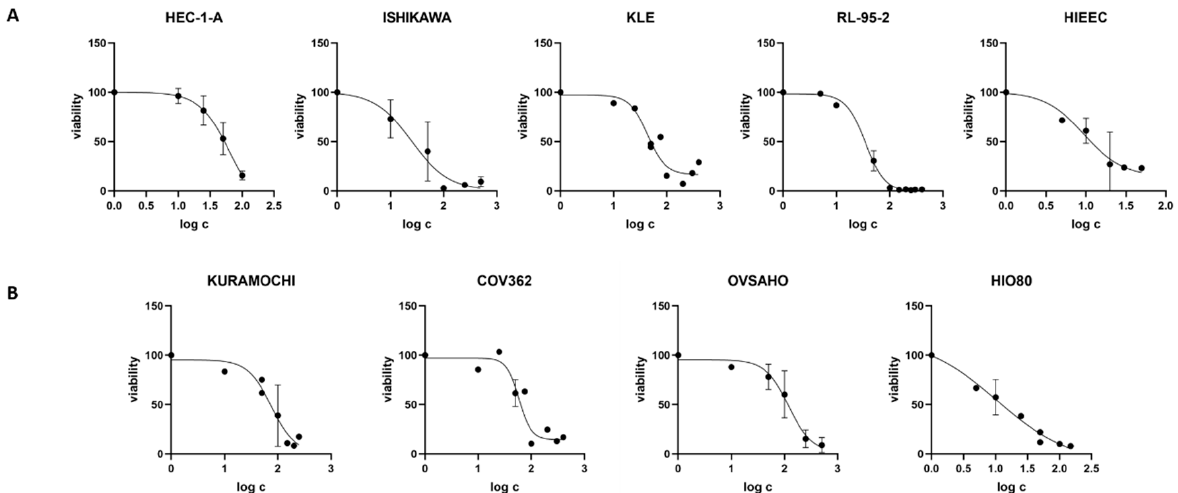
Figure 2. Cell viability after treatment with Cimicifuga racemosa extract. ( A ) The endometrial cancer cell lines HEC-1-A, Ishikawa, KLE, and RL-95-2 and the control cell line HIEEC. ( B ) The ovarian cancer cell lines Kuramochi, COV362, and OVSAHO and the control cell line HIO80. The mean values of at least two independent experiments with standard deviations are shown. Table 3. Cell lines with defined CC 50 values for Cimicifuga racemosa